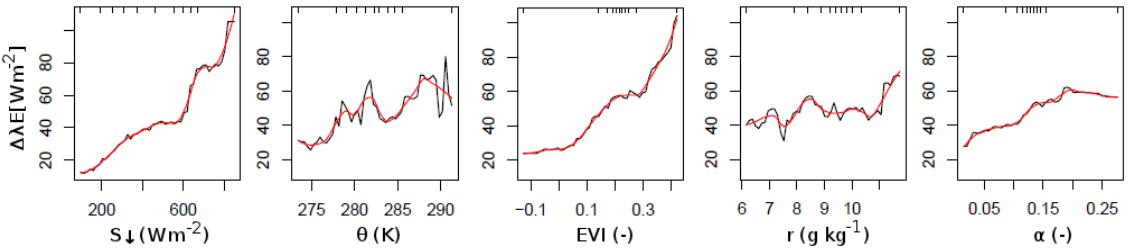
Figure 6. Environmental mean response functions for the latent heat flux. The functions show the responses to changes in the downward shortwave solar radiation (S ↓ ), potential temperature ( θ ), enhanced vegetation index (EVI), mixing ratio ( r ), and land-surface albedo ( α ). The black line shows the variable response of the BRT and the red line is an equidistantly smoothed representation of the black line. Rug plots along the top margins of the plots show the distribution of the variables in deciles.